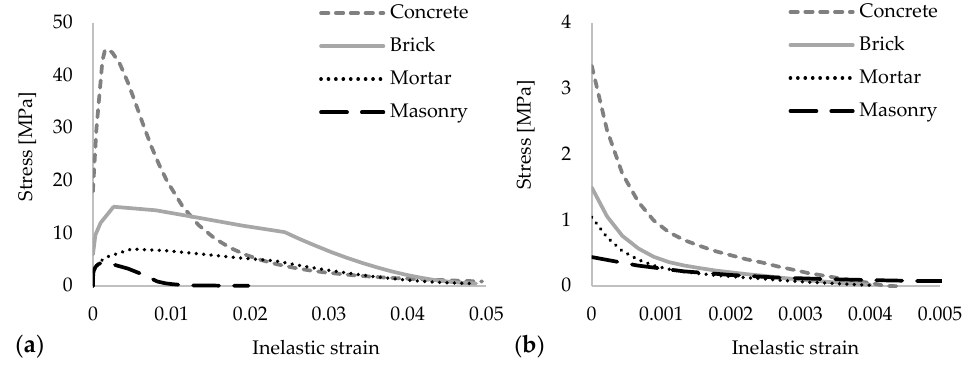
Figure 5. Material inelastic stress-strain curves: ( a ) compression and ( b ) tension.